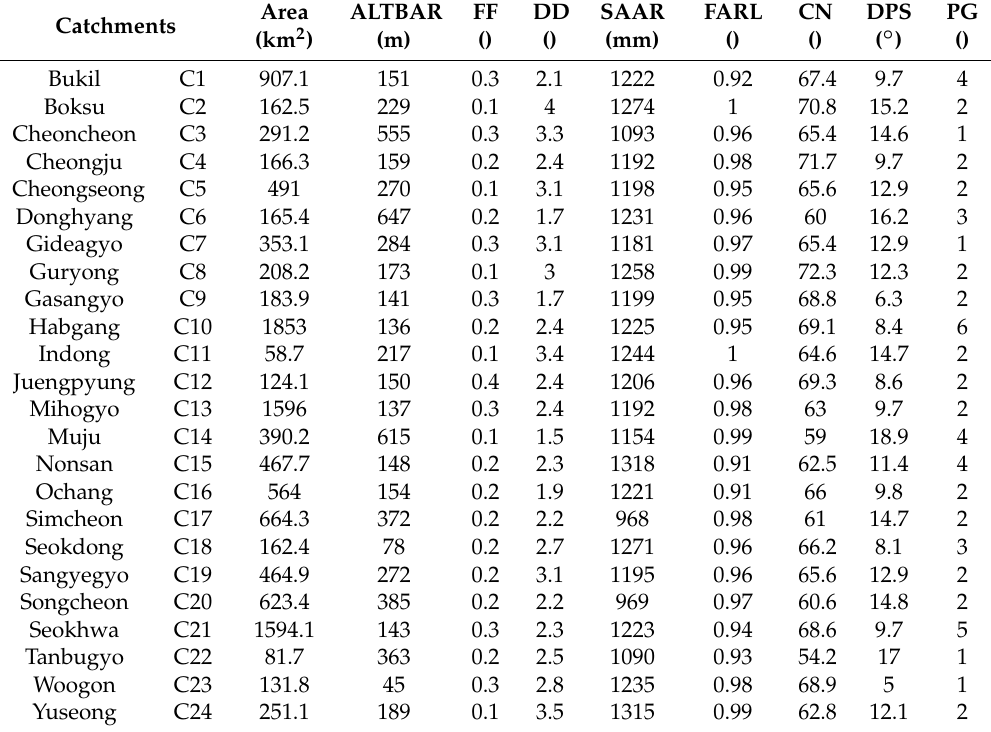
Table 1. Catchment characteristics of the 24 catchments.